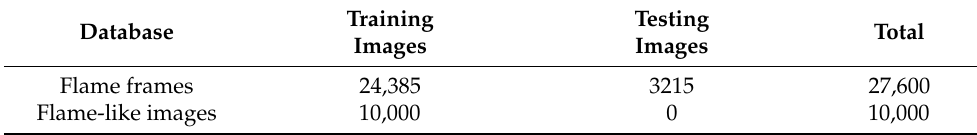
Table 2. Separation of flame and flame-like images in the database.